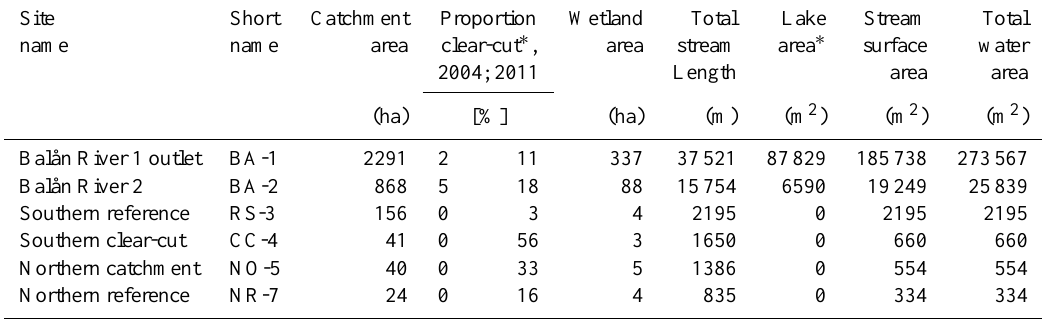
Table 1. Catchment characteristics of the six nested Balsjö catchments.